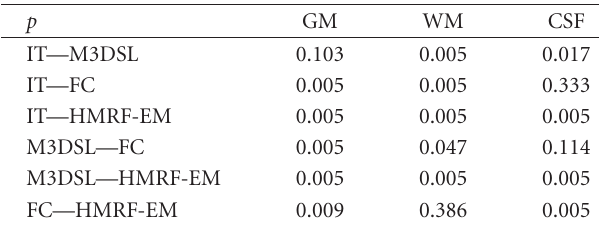
Table 2: Significance values for GM, WM, and CSF for 6 pairs of segmentation